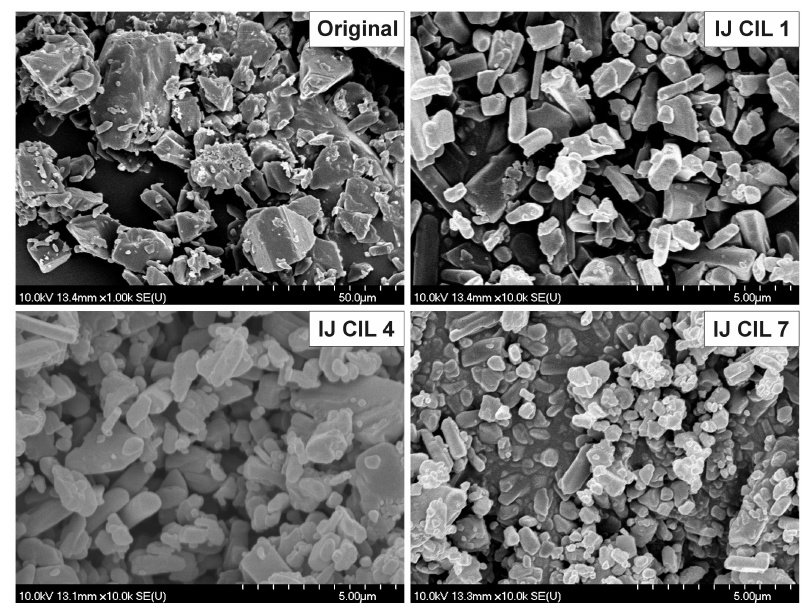
Figure 5. SEM images of original cilostazol crystals and the products made with impinging jet crystallization.